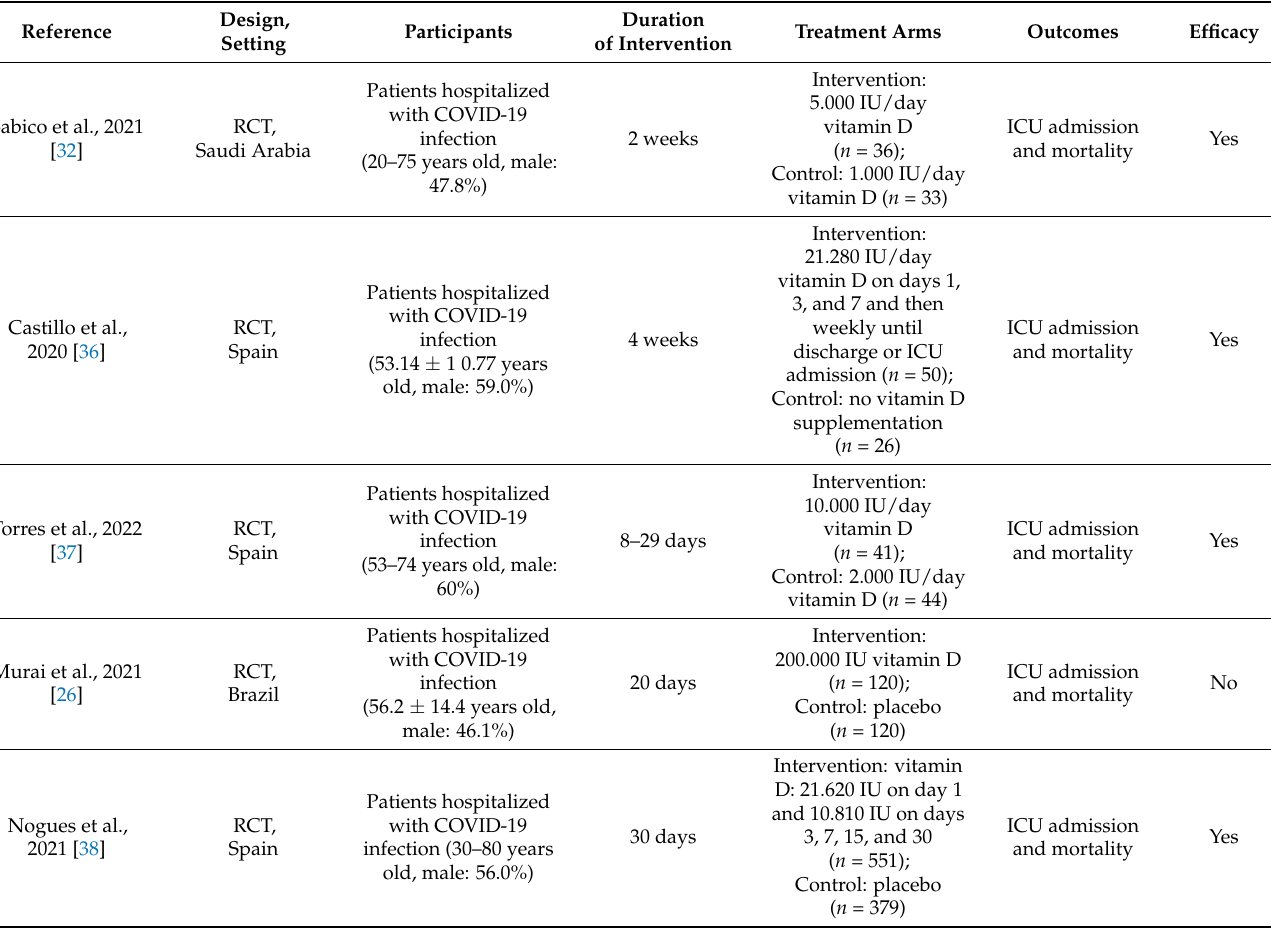
Table 2. Characteristics of studies of the effects of vitamin D supplementation on COVID-19-related ICU admission and